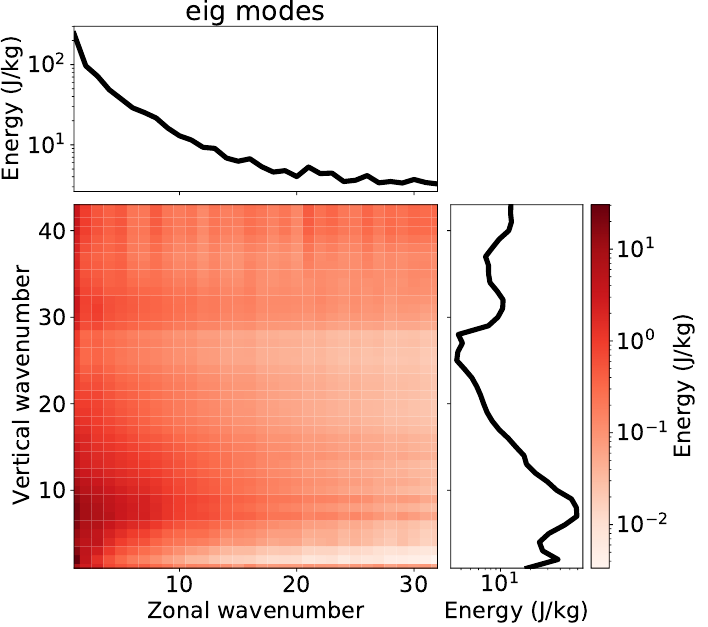
Figure 12. Energy spectrum of the eastward inertio-gravity wave component of the atmospheric oscillations as a function of the zonal wavenumber and vertical